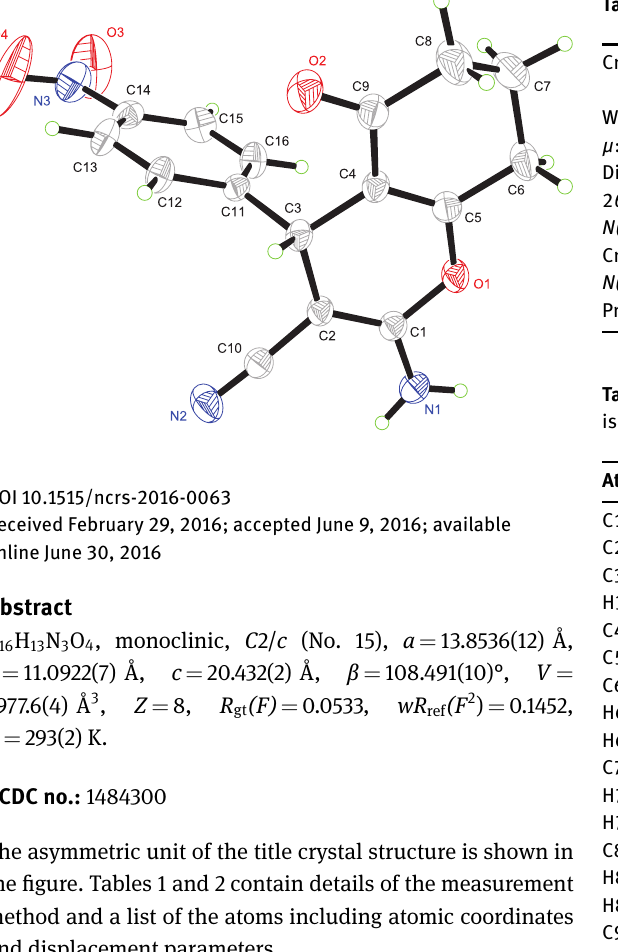
Table 1: Data collection and handling.